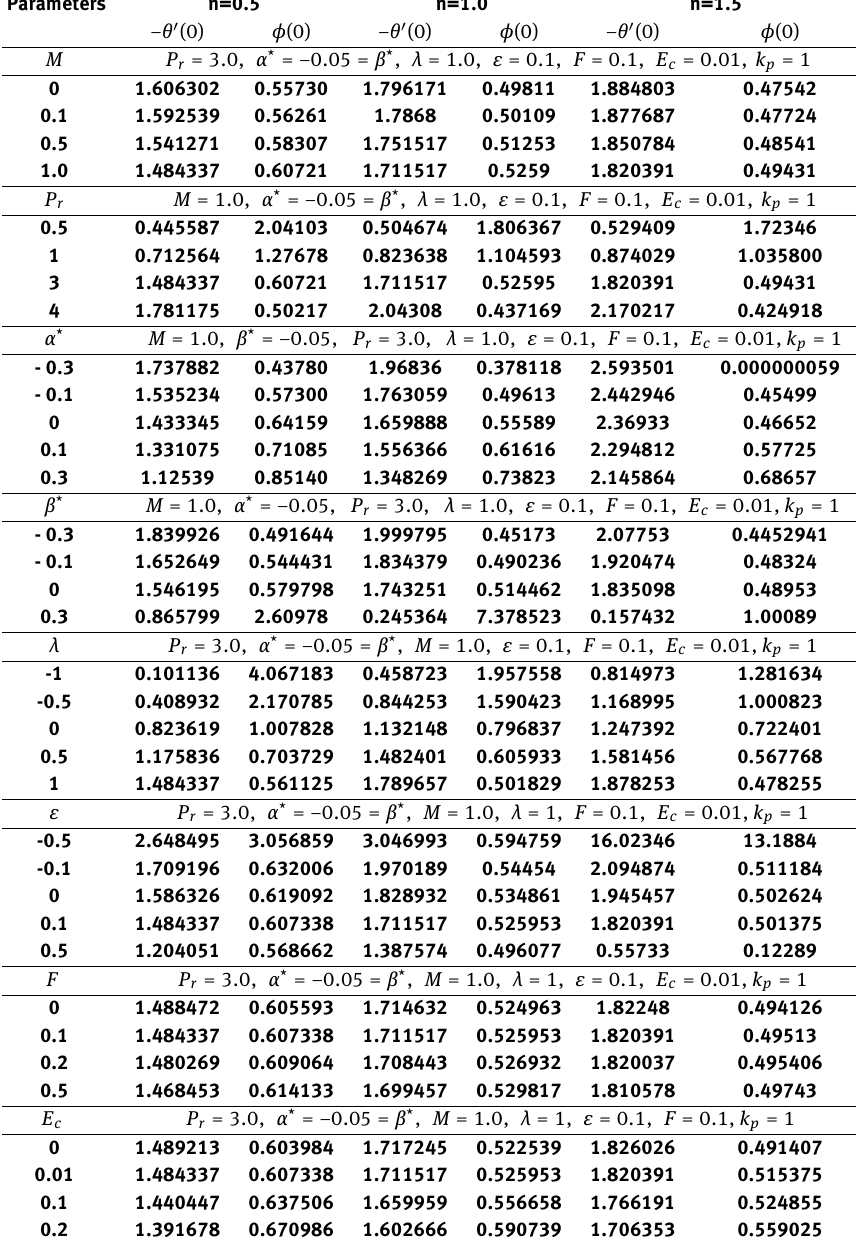
Table 4: Values of − θ ′ (0) and ϕ (0) for various values of M , P r , α , β , λ , ε , F and E